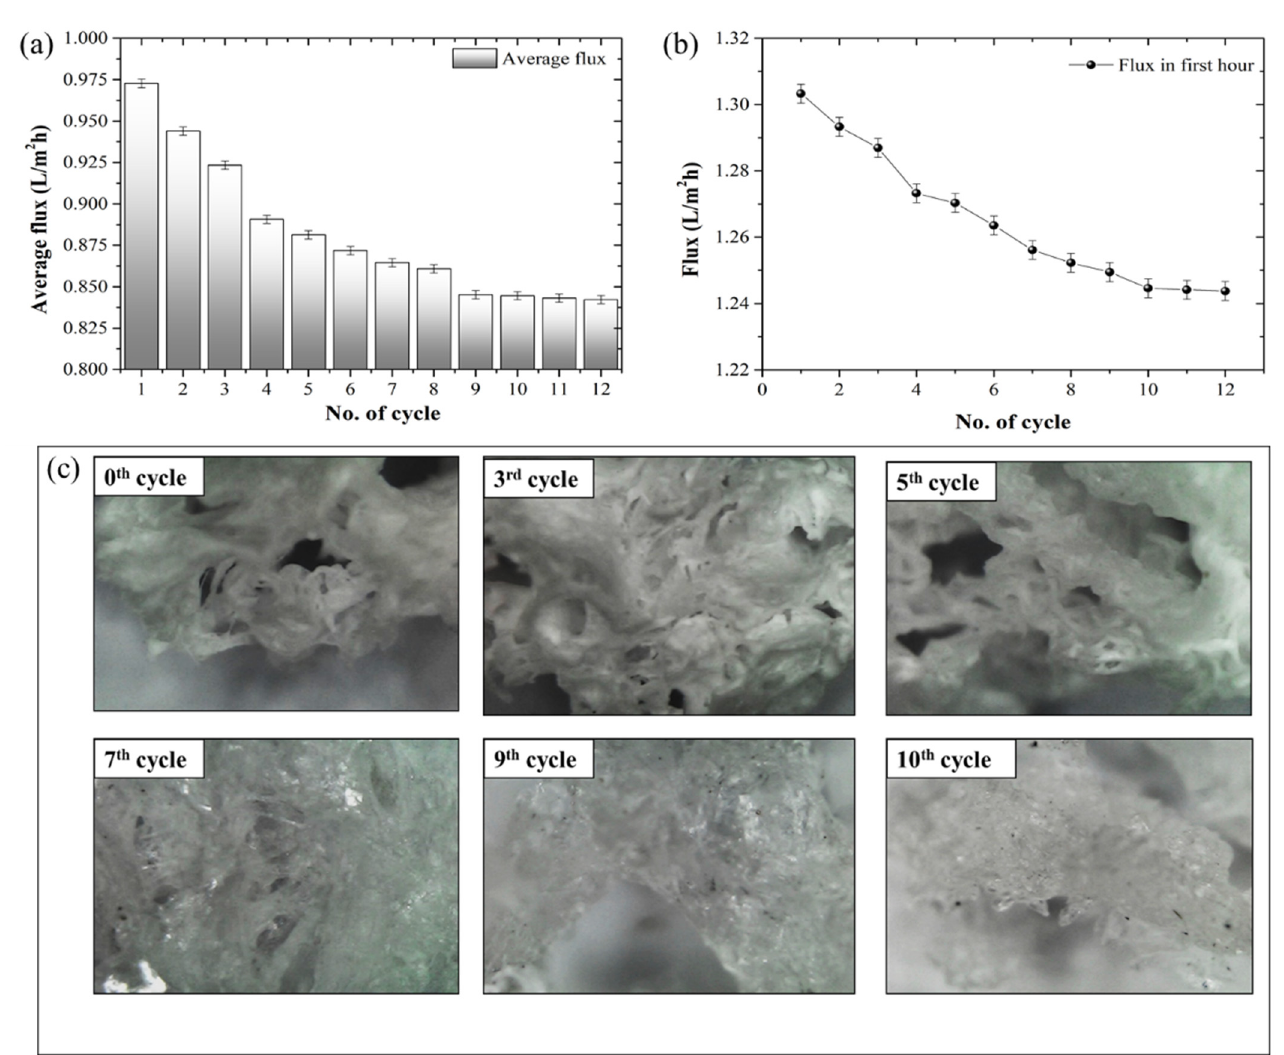
Figure 7. ( a ) Change in average flux with each FO and regeneration cycle, ( b ) change in flux over the first hour, and ( c ) digital microscopic image to determine the change in morphological structure with each cycle, at 100×.